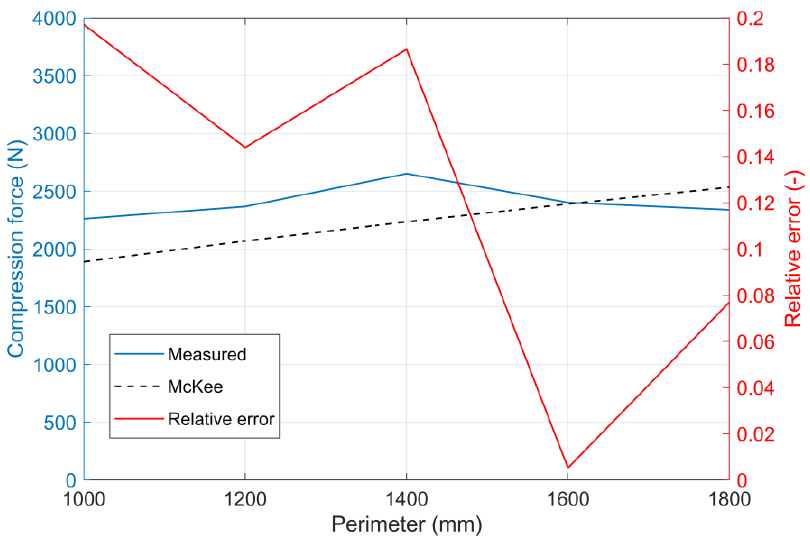
Figure 9. The relative error of the BCT results obtained with the simplified McKee formula ( k = 7) for the uncut versions of each box type.